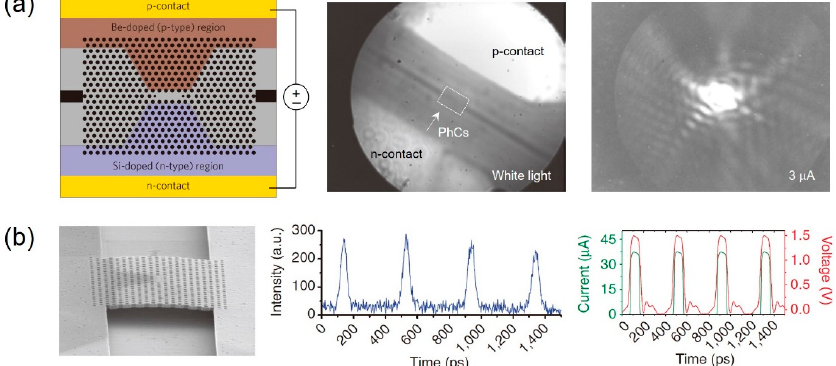
Figure 6. Lateral current injection PhC nanolasers and nano-LED modulators. ( a ) Schematic drawing of a laterally p - i - n -doped PhC nanocavity (left). Red and blue areas represent Be-doped ( p -type) and Si-doped ( n -type) regions, respectively. The PhC nanocavity is located in the narrow intrinsic region between the p - and n -type doped regions. White light image of the fabricated QD PhC nanocavity laser device (white-dotted box) with p - and n -contacts, respectively (middle). Far-field radiation image of the above threshold lasing action from the PhC nanocavity (right). The image is captured by an infrared (IR) camera at an applied current of 3 μ A at 50 K [32]. Figure reproduced with permission from Springer Nature Limited. ( b ) SEM image of electrically pumped GaAs PhC cavity LED (left). Ultrafast direct electrical amplitude modulation of PhC LED; intensity signal (middle) and electrical bit sequence signals (right) [33]. Figure reproduced with permission from Springer Nature Limited.